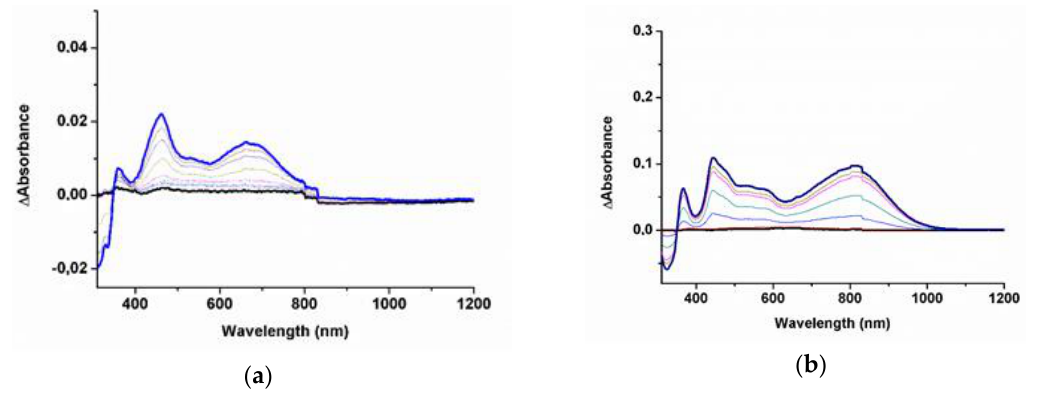
Figure 4. Differential UV–Vis-NIR spectra recorded during the oxidation of